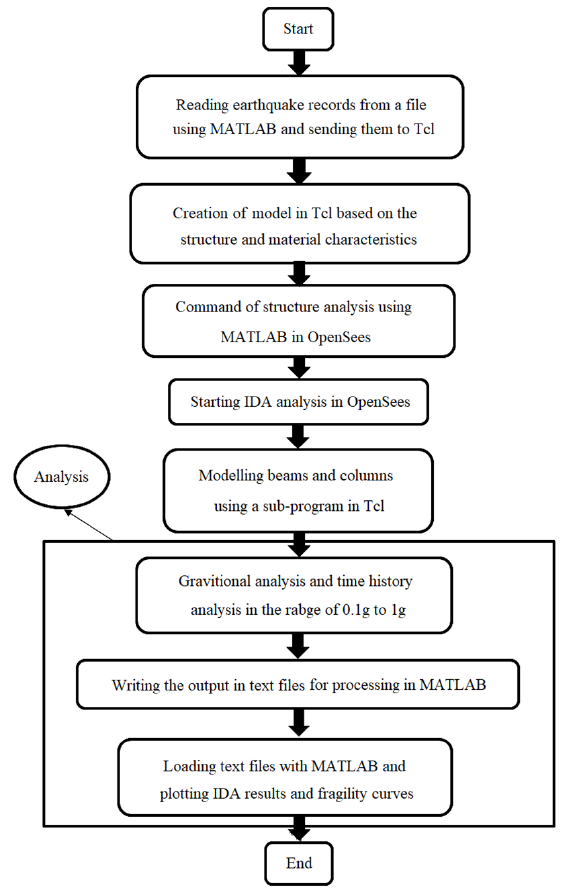
Figure 2: Incremental dynamic analysis